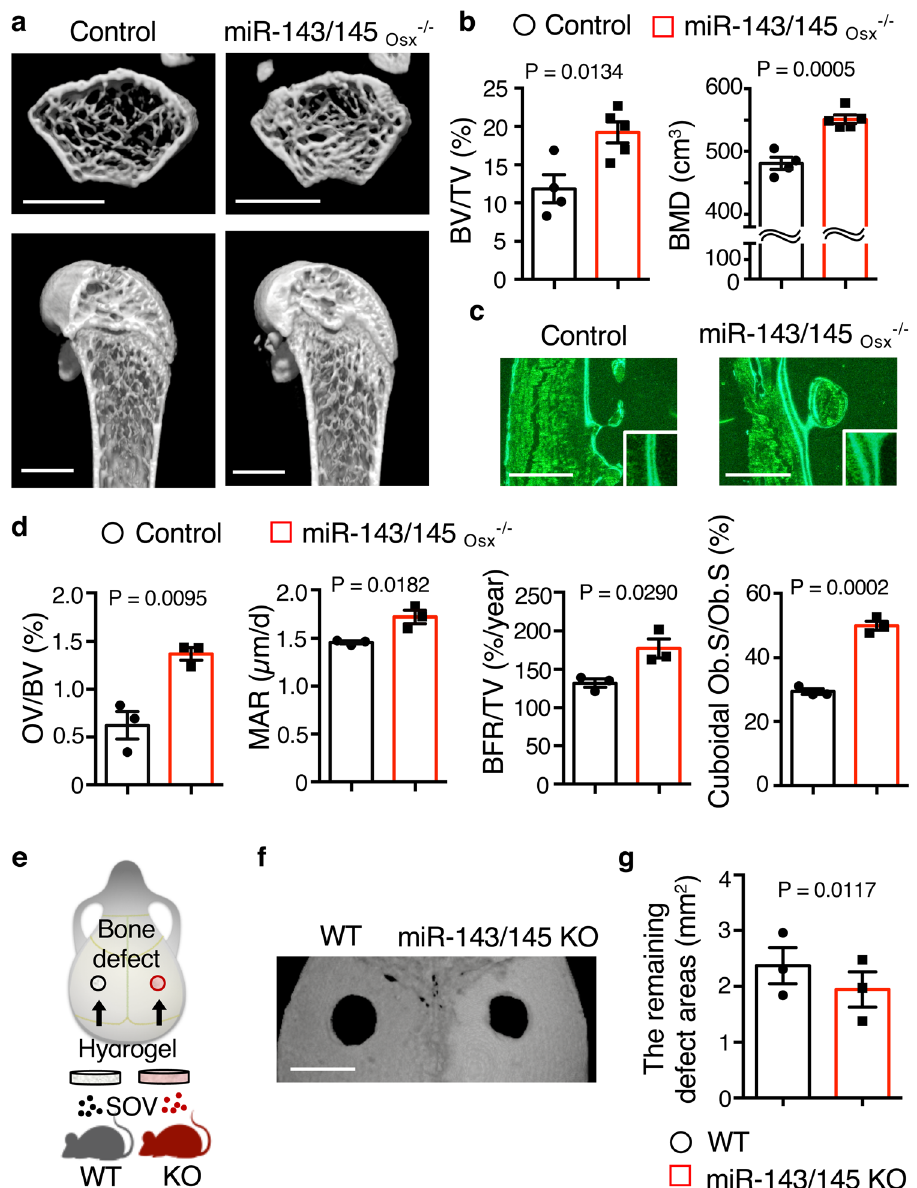
Fig. 5 miR-143/145 conditional KO increases bone mass and promotes mineralization in mice. a Representative micro-CT images of the femurs of 9-week- old control ( n = 4 biological replicates) and osteoblast-speci fi c miR-143/145 KO (miR-143/145 Osx − / − ) mice ( n = 5 biological replicates). Scale bars: 1000 μ m. b Micro-CT-based assessment of metaphyseal regions of distal femurs of 9-week-old control ( n = 4 biological replicates) and miR-143/145 Osx − / − ( n = 5 biological replicates) mice. BV: bone volume; TV: tissue volume; BMD: bone mineral density. c , d Bone morphometric analysis of metaphyseal regions of distal femurs of 9-week-old control and miR-143/145 Osx − / − mice ( n = 3 biological replicates per group). Calcein double signals in a representative femur section from a control or miR-143/145 Osx − / − mouse on cortical surfaces and magni fi ed view (inset). Scale bars: 100 µ m ( c ). Bone formation parameters ( d ). OV: osteoid volume; MAR: mineral apposition rate; BFR: bone formation rate; Ob.S: osteoblast surface. e Transplantation model of calvarial defects. Arti fi cial bilateral defects on mouse calvaria were treated with total SOVs from miR-143/145 KO or WT mice. f Representative micro-CT image of calvarial defects at 2 weeks after treatment with SOVs from miR-143/145 KO or WT mice ( n = 3 biological replicates per group). Scale bar: 2000 µ m. g Remaining defect areas. miR-143/145 KO: mice treated with total SOVs from miR-143/145 KO mice; WT: mice treated with SOVs from WT mice ( n = 3 biological replicates per group). Data are means±SEMs. Statistical signi fi cance was determined by two-tailed unpaired t -test in ( b , d ) or by two-tailed paired t -test in ( g ). − / − mice (i.e., increased bone mass, MAR, fi ndings in Cbfb col1a1 Runx2 mRNA expression, and ratio of mOBs to total osteoblast area [cuboidal Ob.S/Ob.S]). MiR-143 was previously shown to inhibit Sp7 mRNA expression in osteoblasts, as indicated by luciferase assay results using human Sp7 mRNA sequences 42,43 .